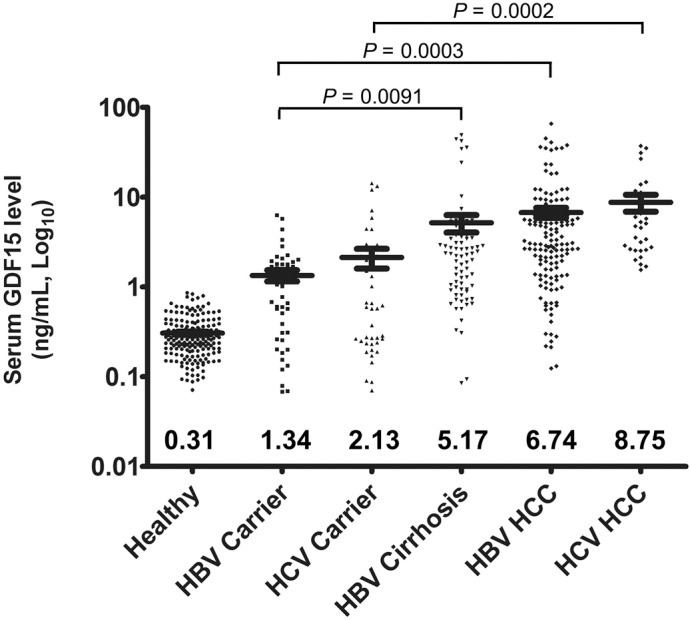
Serum GDF15 level alterations in patients with hepatitis virus-related diseases.Scatter plots show the serum GDF15 levels in healthy subjects and patients with various liver diseases by ELISA. The black line indicates the mean, for which the value is indicated at the bottom of the scatter plot. The P values for HBV carriers vs. HBV cirrhosis, HBV carriers vs. HBV HCC and HCV carriers vs. HCV HCC are indicated.